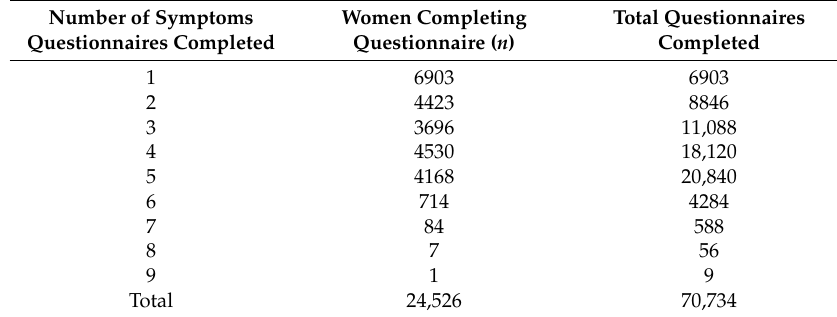
Table 3. Frequency of symptom questionnaire completion.